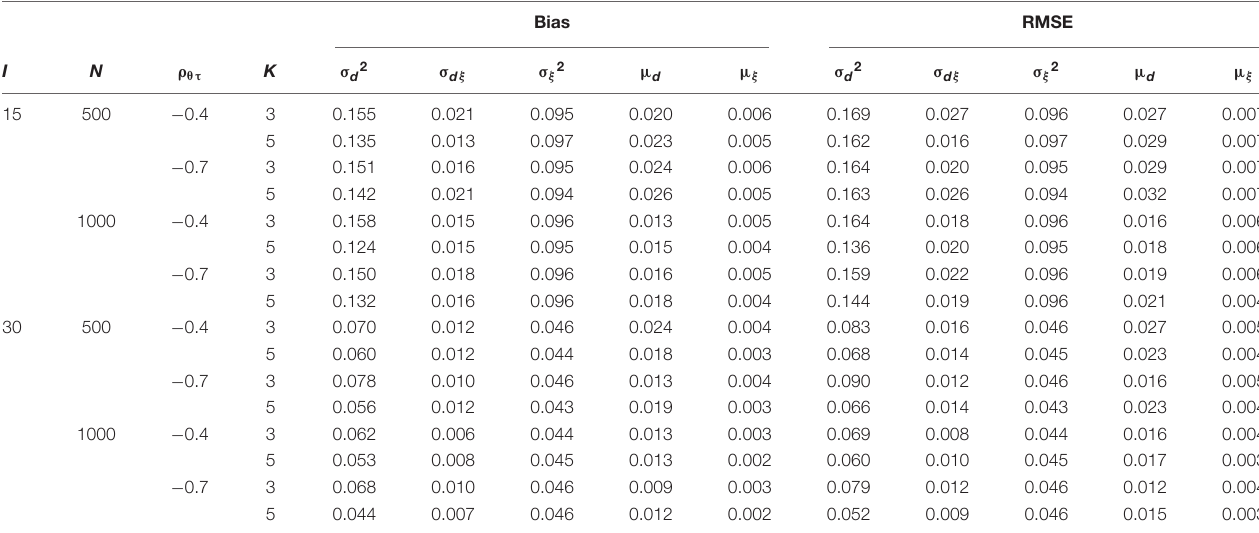
TABLE 7 | Recovery of item mean vector and item variance-covariance in simulation study 1. Bias